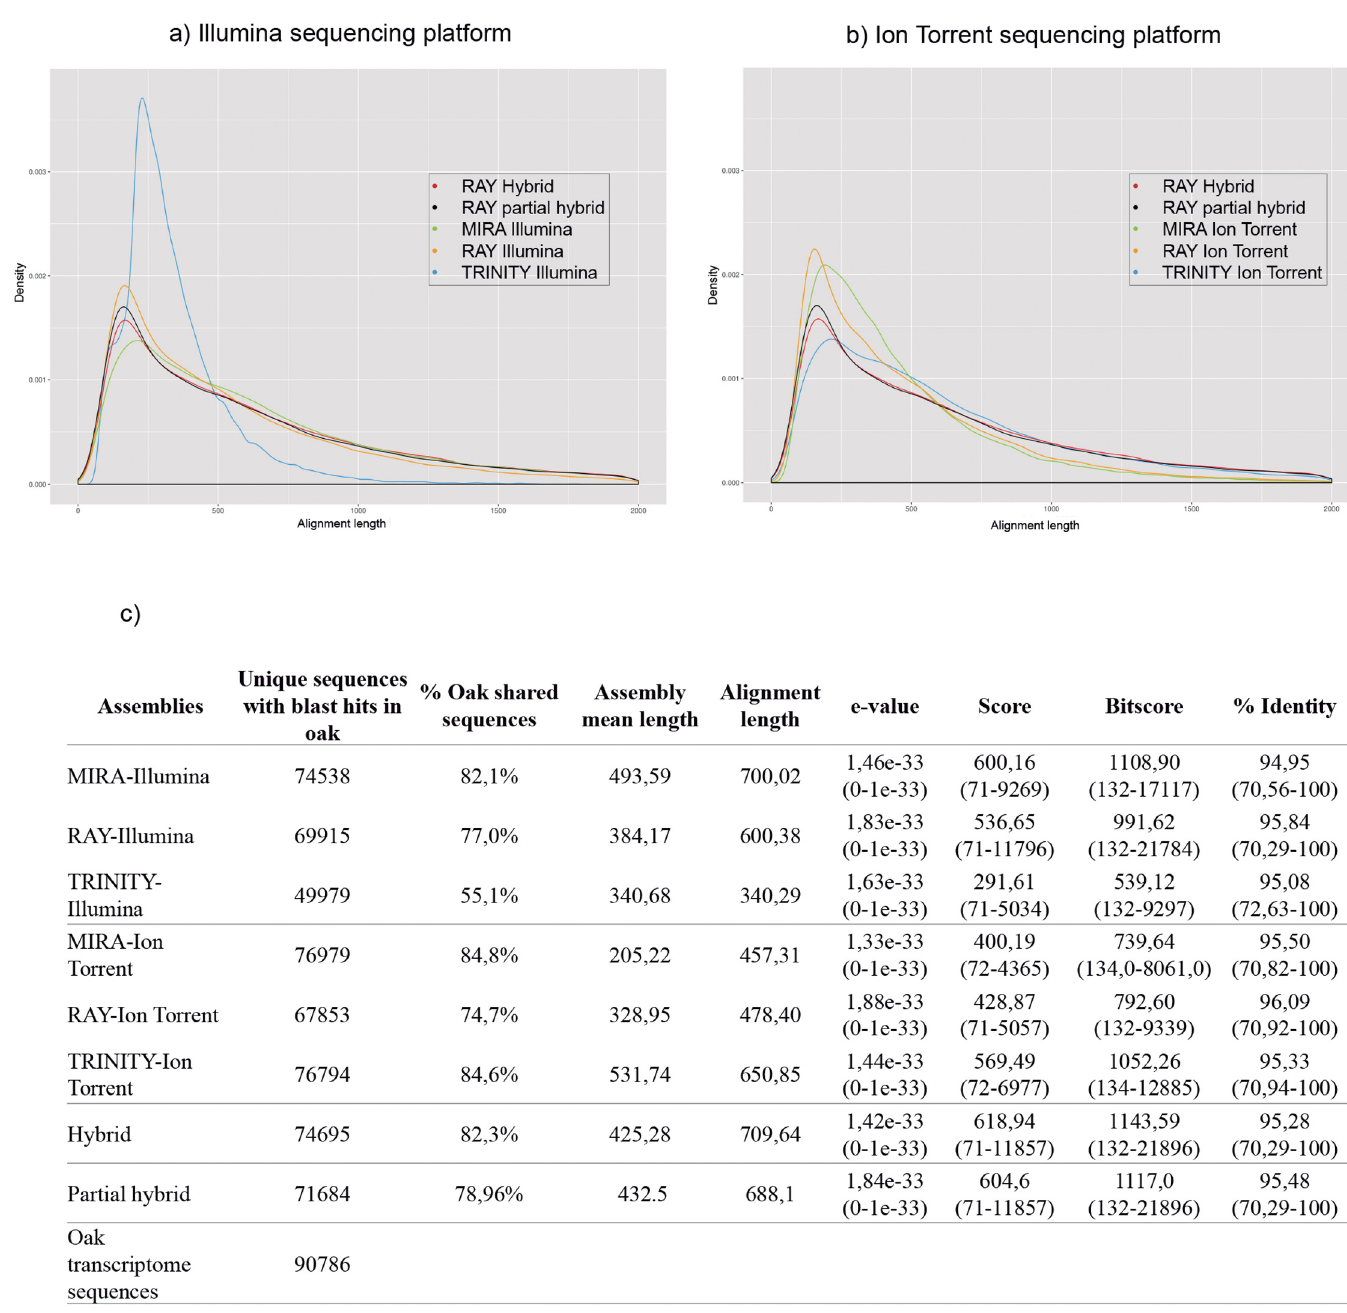
Fig 1. Alignment between Q . robur and Q . petrea transcriptomes (oak transcriptome) and Q . ilex (holm oak) transcriptome using MIRA, RAY, TRINITY and RAY hybrid assemblies from Illumina ( a ) and Ion Torrent ( b ) reads. Distribution of percent sequence identity between oak and Q . ilex (MIRA, RAY, TRINITY, RAY hybrids) transcriptomes ( c